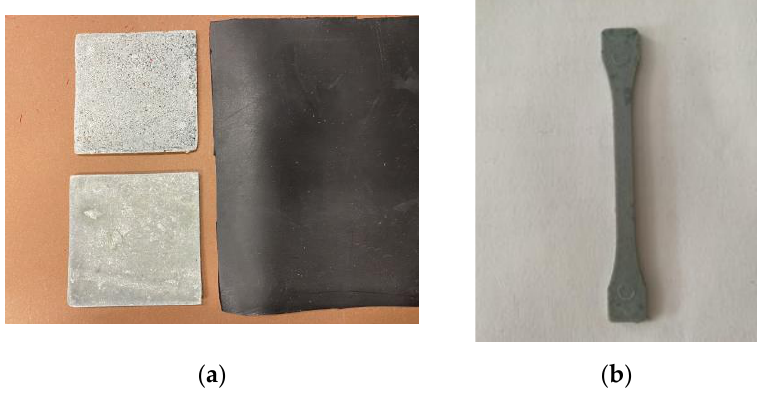
Figure 5. Optical microscope images (5x magnification): ( a ) wet blue fibers; ( b ) finished leather fibers.